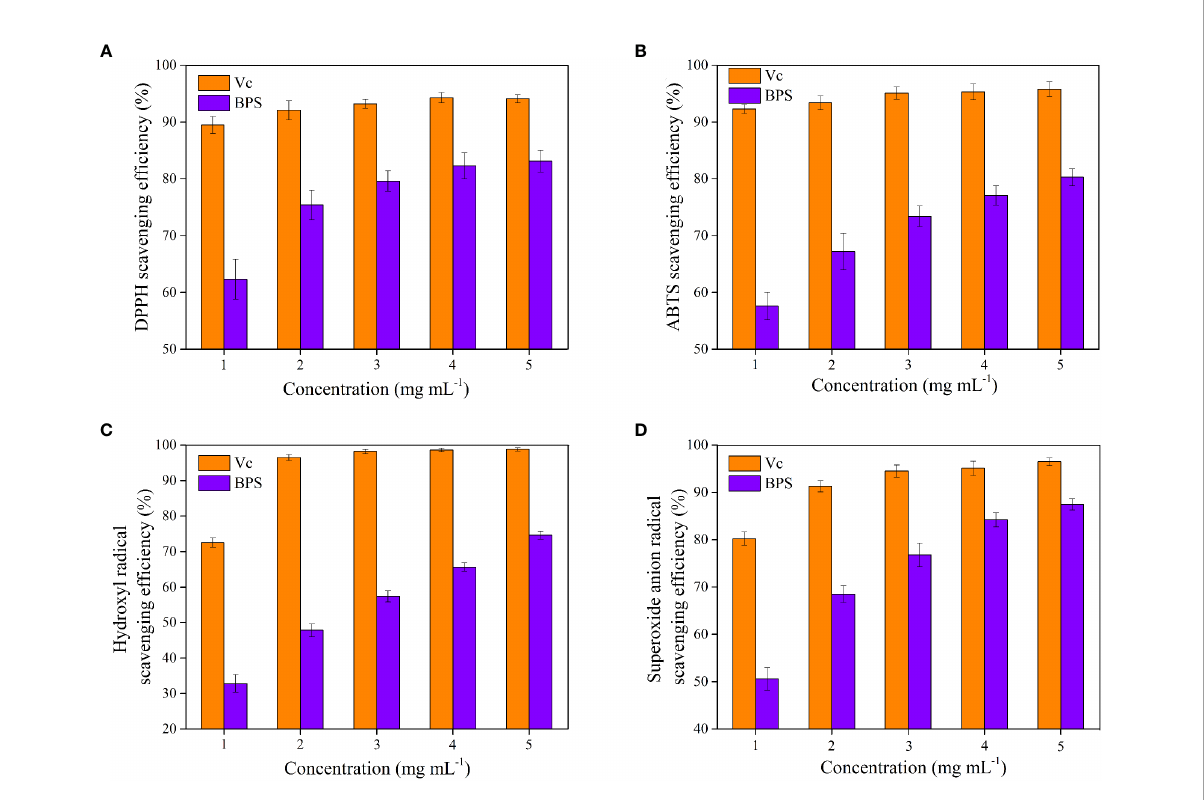
FIGURE 8 Antioxidant activities of BPS in vitro . DPPH scavenging activity (A) ; ABTS scavenging ef fi ciency (B) ; Hydroxyl radical scavenging ef fi ciency (C) . Superoxide anion radicals scavenging ef fi ciency (D) . All values are mean values (n =